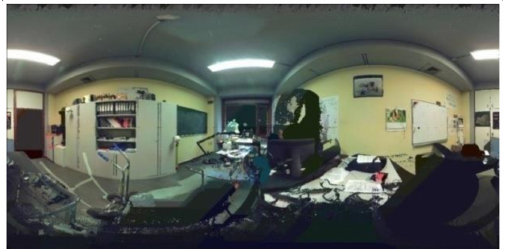
Figure 6. Panoramic image after applying the two